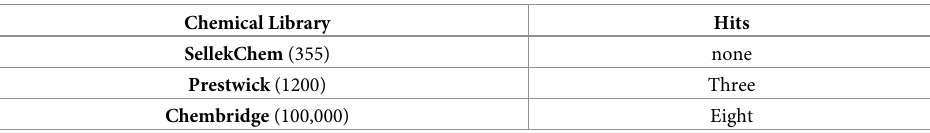
Table 1. Chemical libraries screened by FluorIA and hits